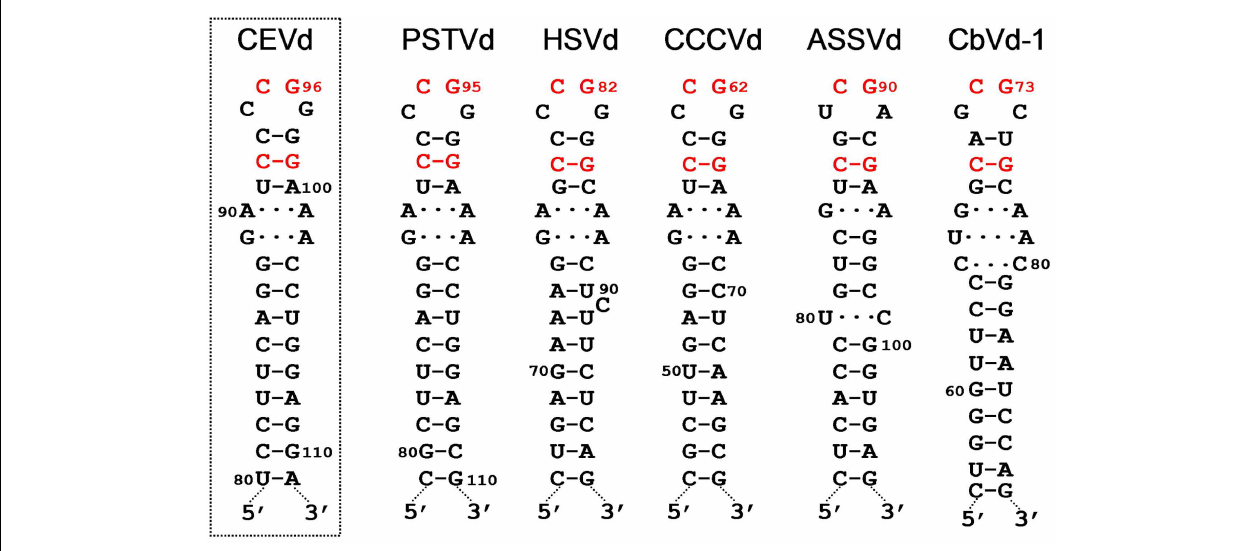
FIGURE 2 | Hairpin I structures of the five type species of the family Pospiviroidae . This element of secondary structure is formed by the upper CCR strand and a flanking inverted repeat of PSTVd, HSVd, CCCVd, ASSVd, and CbVd-1 ( Coleus blumei viroid 1). Red fonts indicate conserved nucleotides in structurally similar positions. Continuous and broken lines representWatson–Crick and non-canonical base-pairs,